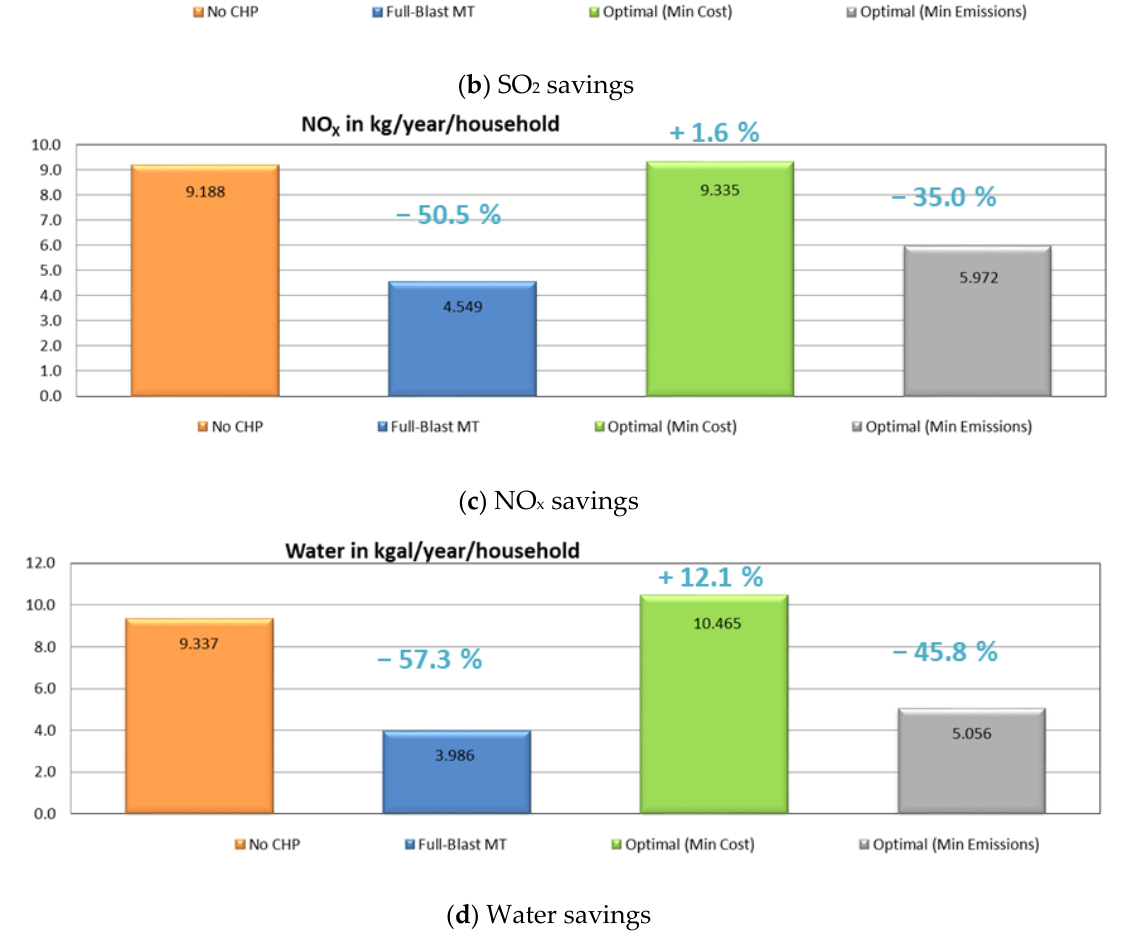
Figure 17. Annual emissions savings.